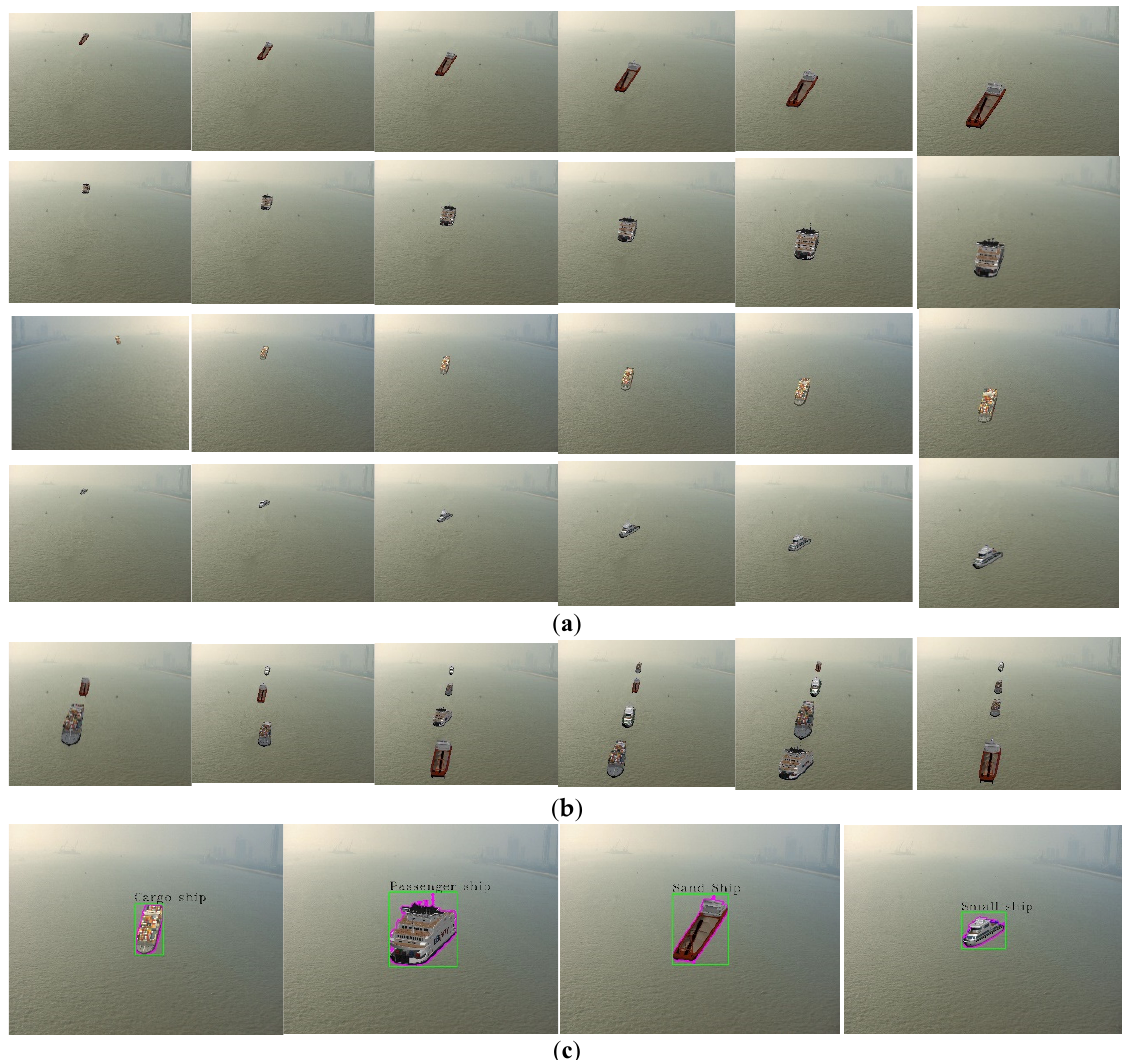
Figure 10. Four typical SRS images generated by the proposed method: ( a ) SRS images with a single object; ( b ) SRS images with multiple objects; ( c ) annotation samples.